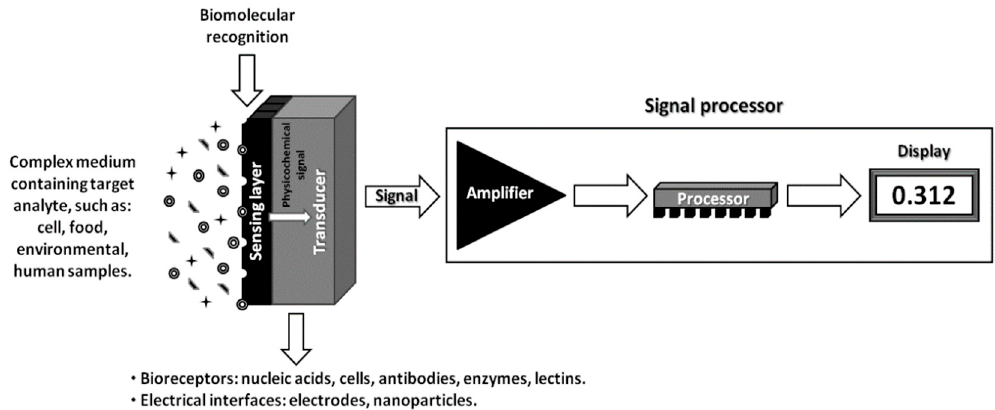
Figure 2. A schematic of a biosensor. Adapted with permission from [55]. Copyright 2011 Intech.